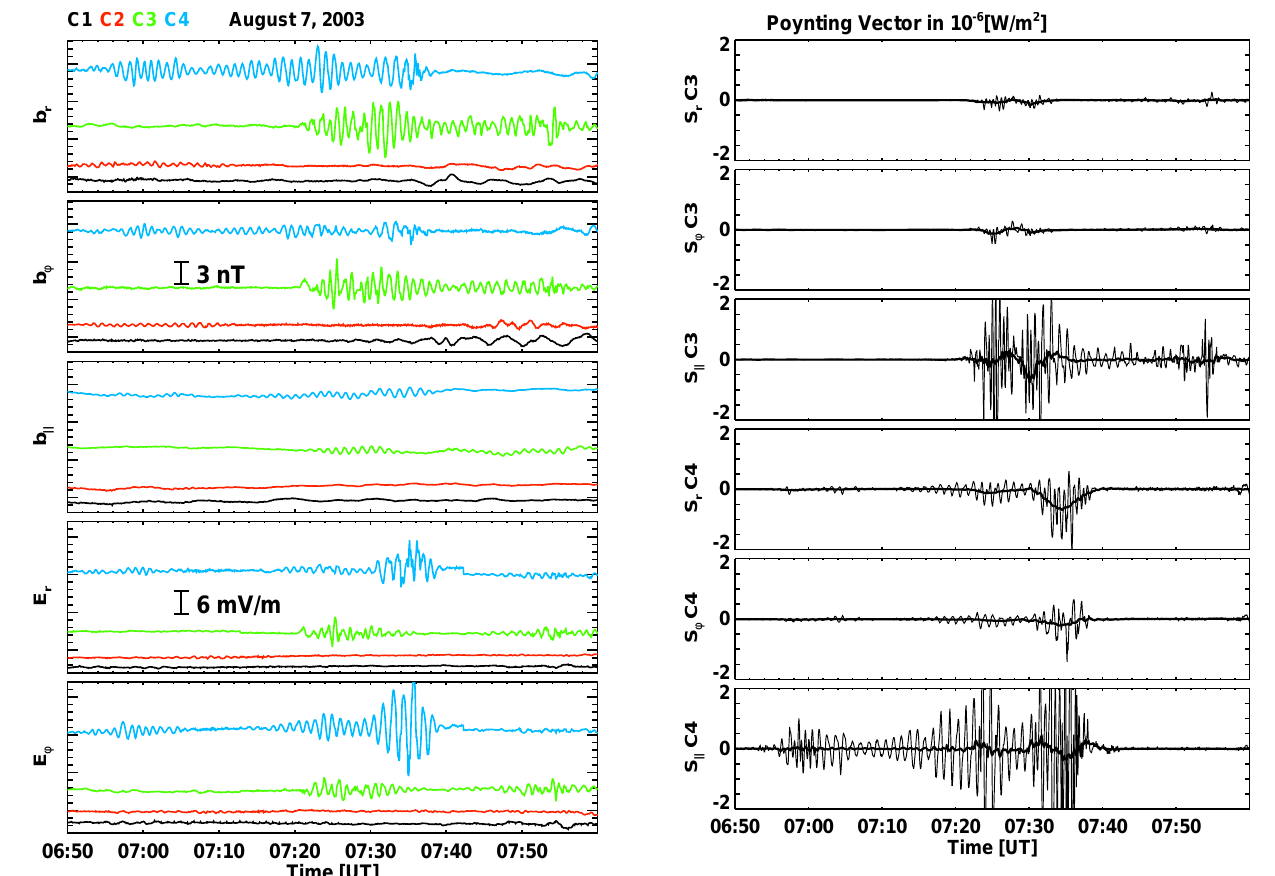
Fig. 3. FGM and EFW measurements for the four Cluster space- craft (C1: black, C2: red, C3, green, C4: blue), transformed into a Mean-Field-Aligned coordinate system. The bars denotes ampli- tudes of magnetic and electric field, respectively.